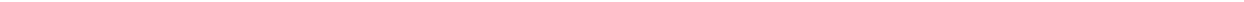
Fig. 2 MK2/3 are key transducers of p38 signaling after UV light. a Schematic representation of the strategy used to identify UV-light-induced, MK2/3/5- dependent phosphorylation sites. SILAC-labeled U2OS cells were mock-treated (Light), pretreated with the p38 inhibitor (Medium) or the MK2/3/5 inhibitor (Heavy), and subsequently irradiated with UV light (40 J/m 2 , 1 h recovery). The phosphoproteome analysis was performed as described in Fig. 1c. b The scatter plot shows the logarithmized SILAC ratios of quanti fi ed phosphorylation sites. The color-coding indicates the density. A majority of UV-light- induced, p38-dependent phosphorylation sites signi fi cantly decreased in abundance also after MK2/3/5 inhibition, whereas a smaller fraction of sites decreased in abundance only after p38 inhibition. c The bar graph shows the percentage of UV-light-upregulated, p38-dependent sites that are up-, non-, or downregulated after MK2/3/5 inhibition. Nearly 60% of p38-dependent phosphorylation sites are also dependent on MK2/3/5. d Sequence motif analysis of p38- and MK2/3/5-dependent phosphorylation sites. The analysis was done as described in Fig. 1e. The sequence surrounding the phosphorylated residue shows an enrichment of glutamine (Q) in position – 2, arginine (R) in – 3, and leucine (L) in – 5. e Sequence motif analysis of p38- dependent, MK2/3/5-independent sites phosphorylation sites. The analysis was done as described in Fig. 1e. The sequence surrounding the phosphorylated residue shows an enrichment of aspartic acid (D) in position + 2, + 4, and arginine (R) in – 3. f The scatter plot shows the logarithmized SILAC ratios of quanti fi ed proteins. 14-3-3 interaction partners and p38-dependent interactions are indicated in light and dark red, respectively. Three hundred and eighty-four proteins were signi fi cantly enriched in 14-3-3 pull downs after UV light ( p- value < 0.05, moderated t -test). One hundred and eight out of 384 proteins (28%) bound to 14-3-3 in a p38-dependent manner. g The bar plot shows the number of proteins with the indicated Gene Ontology (GO)-molecular function terms that were enriched among p38-dependent 14-3-3 interaction partners. h The table shows selected RNA-binding proteins that were identi fi ed as p38-dependent interaction partners of 14-3-3. The UniProt ID, protein name, gene name, position(s), and sequence window of UV- light-induced phosphorylation sites identi fi ed in phosphoproteomics screen is